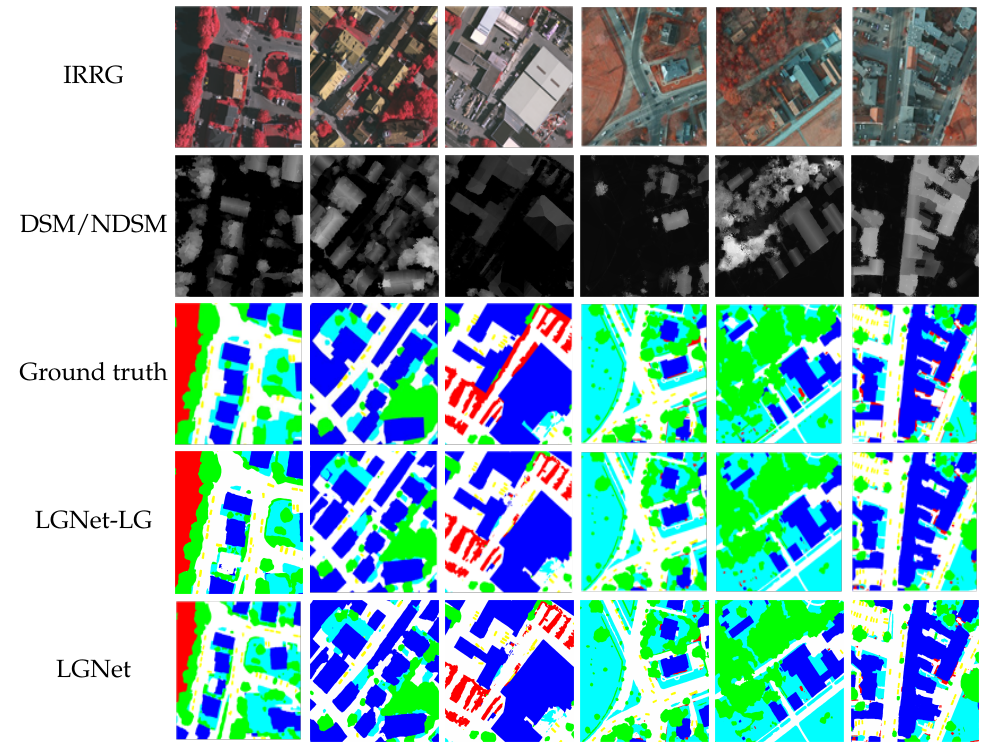
Figure 9. Some samples of the LGNet-LG and LGNet results on the ISPRS Vaihingen and Potsdam dataset. Table 4. The effect of CT loss on the ISPRS Vaihingen and Potsdam